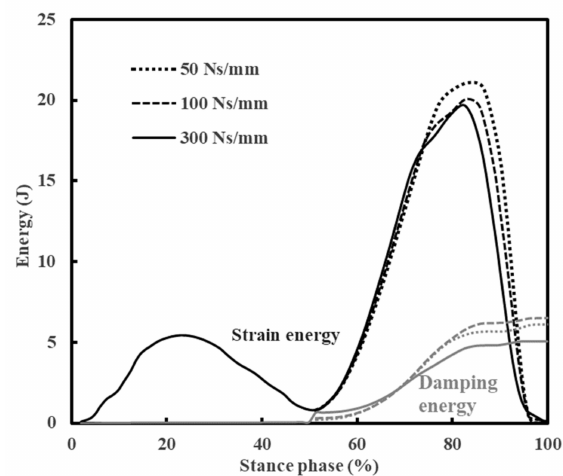
Figure 8. Dissipated damping energy (grey) and recoverable strain energy (black) development in the foot over the stance phase for di ff erent damping coe ffi cients used in the actuated element, strain energy being from CF blade strain, and spring element strain. The element is actuated at mid-stance (0.3 s) and turned o ff at the end of the stance, as the element starts to contract after